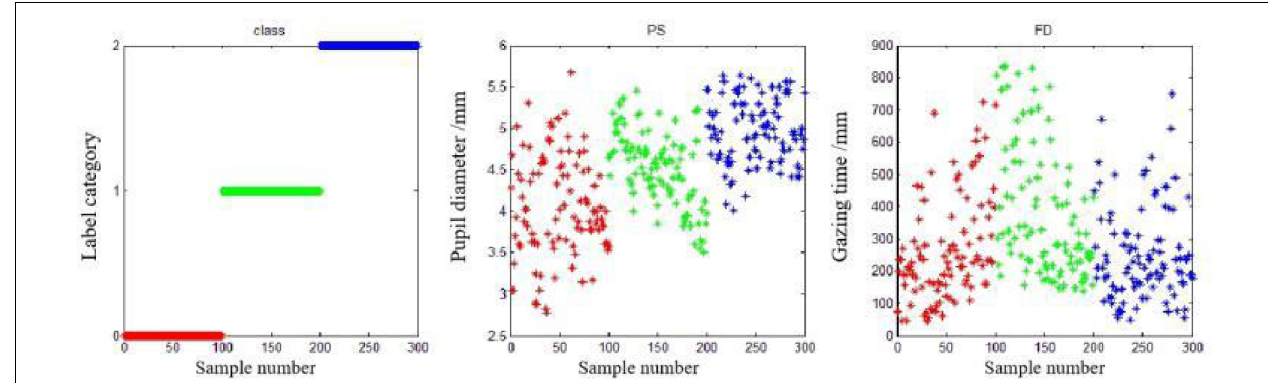
FIGURE 13 | A total of 300 typical data distribution plots of the groups.